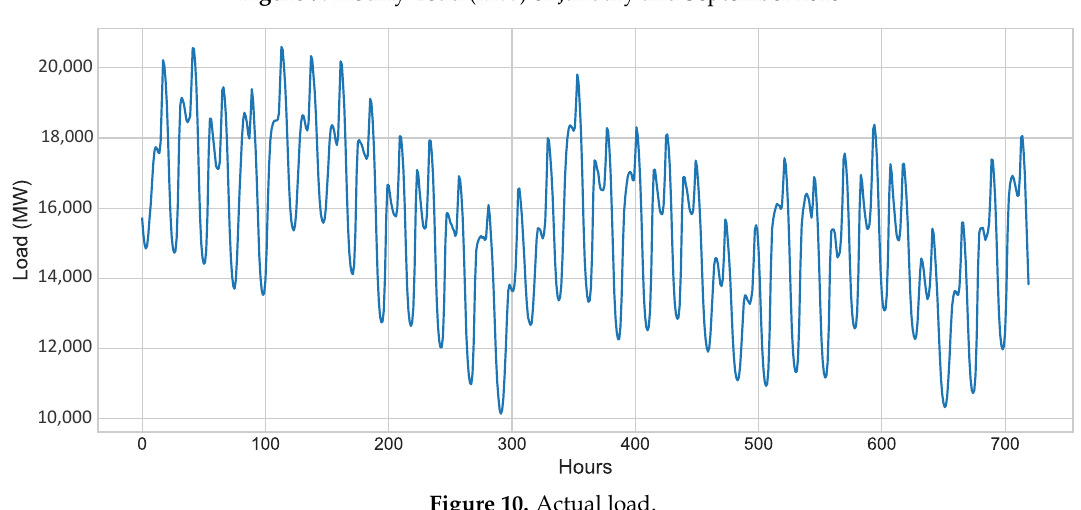
Figure 10. Actual